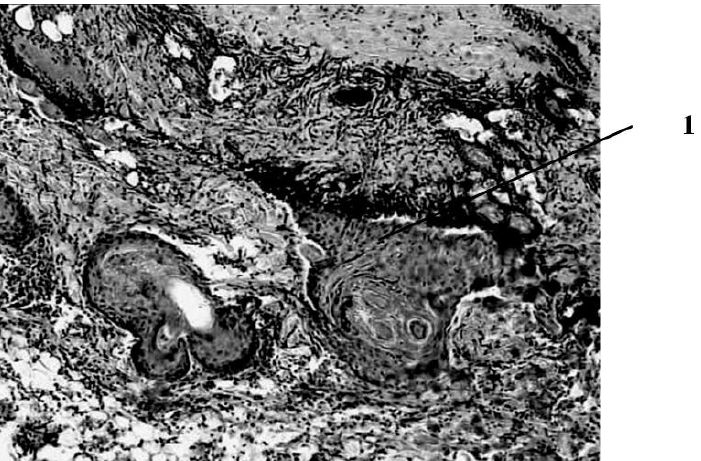
Figure 5. Results of histological examination of the wound seven days after the application of the burn with subcutaneous injection of an ozone – oxygen gas mixture. 1 — proliferation of the epithe- burn with subcutaneous injection of an ozone–oxygen gas mixture. 1—proliferation of the epithelium lium of the preserved parts of the hair follicle bulbs. magn. ×100. of the preserved parts of the hair follicle bulbs. magn. × 100.